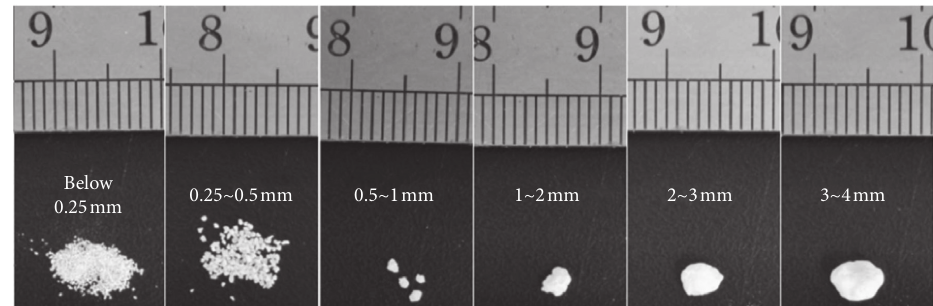
Figure 1: Characteristic particle photographs of calcareous sand.